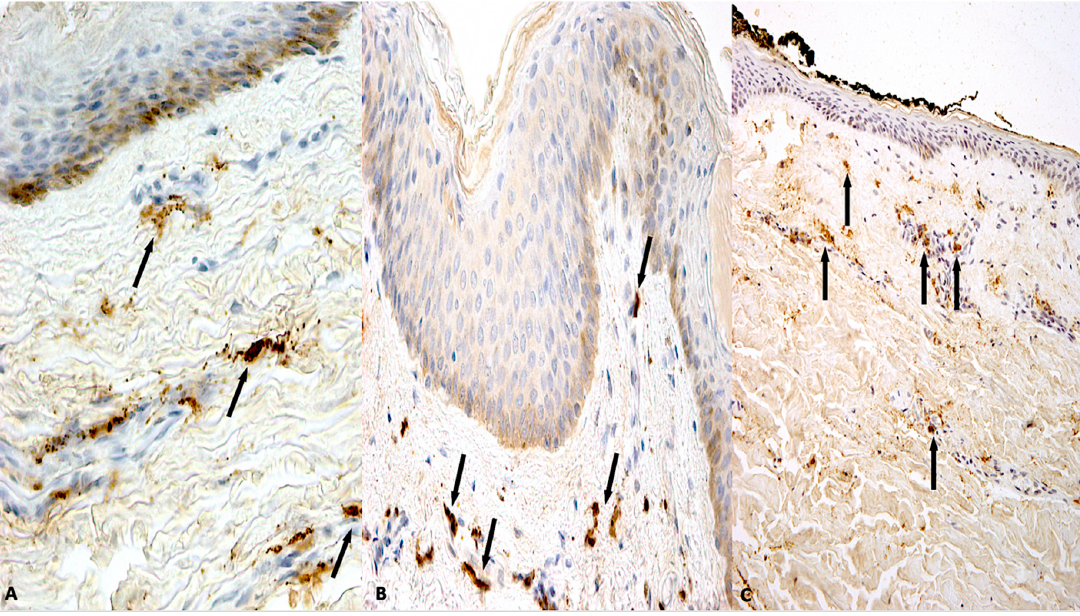
Figure 1. ( A ) Mast cells tagged by tryptase reaction (black arrows) ( × 60). ( B ) Mast cells appeared numerously, especially near the epidermis, along the blood vessels and in the peri-glandular stroma denoting intense tryptase positivity (black arrows) ( × 80). ( C ) CD15 reaction (black arrows) to demonstrate a small number of neutrophils near the vessels (early reaction) ( × 40).